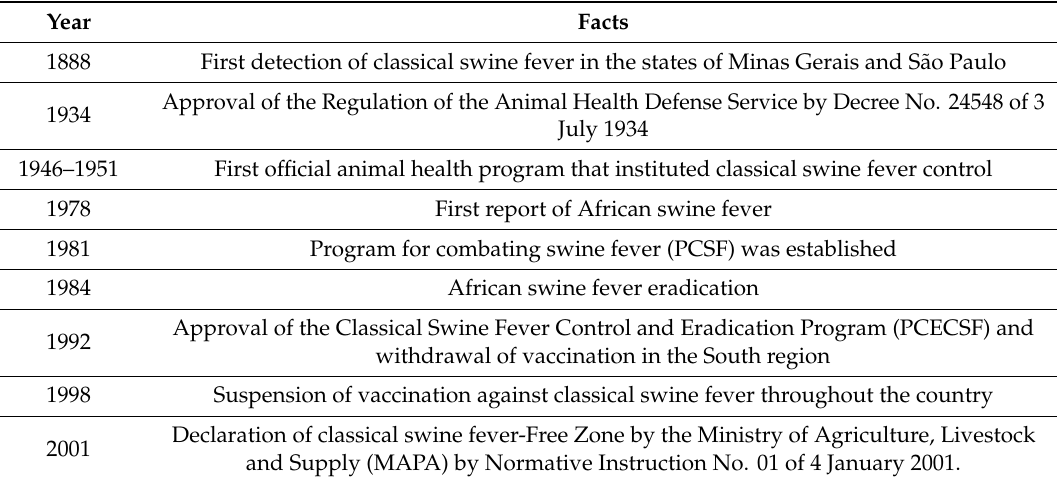
Table 1. Chronological facts regarding classical swine fever and African swine fever in